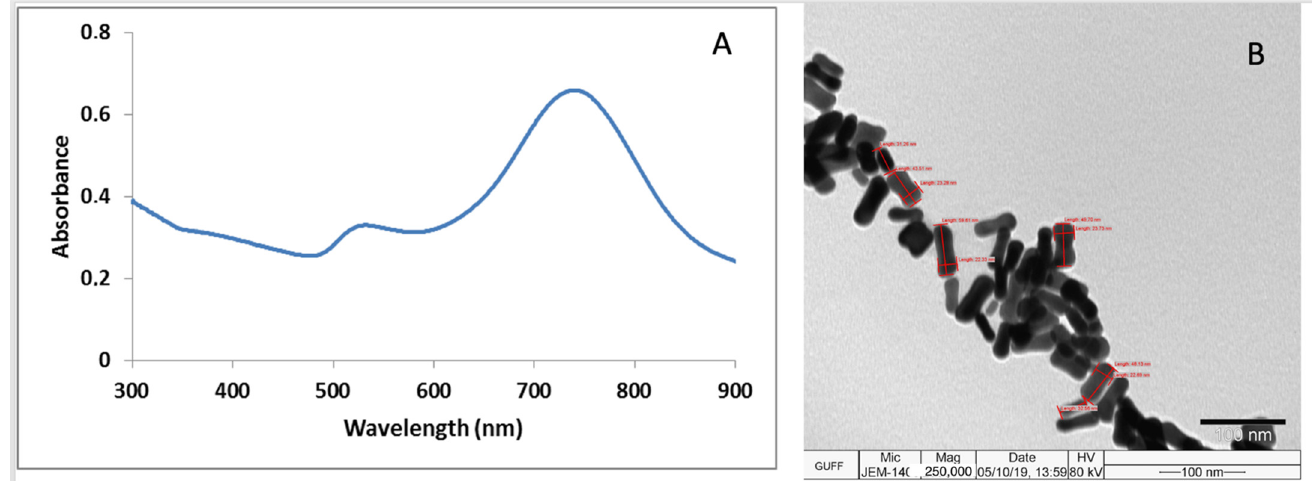
Figure 2. ( A ) UV–Vis spectrum of Au NRs. ( B ) TEM images of Au